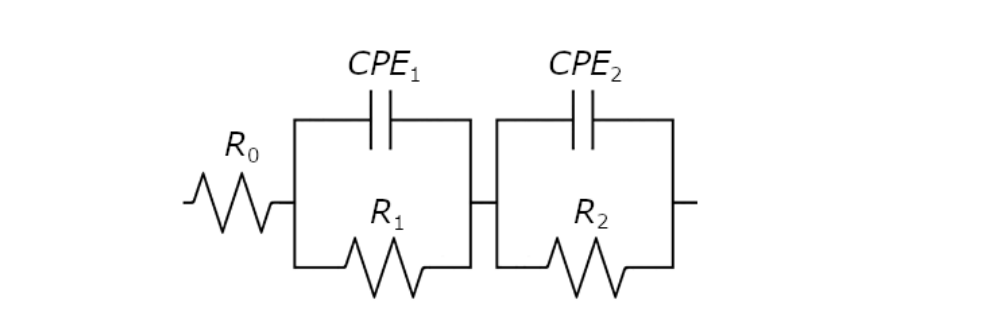
Figure 6. Equivalent electrical circuit model for the corrosion process used for CNLS-fitting. Figure 7. Bode plots versus log frequency ( log f ) for electrodeposited Pd, Pd-Rh, Pd-Ru and Pd-Pt electrodes in deaerated 0.5 M H 2 SO 4 at the open circuit potential: ( a ) Magnitude of impedance (log | Z |); ( b ) Phase angle (  ). Symbols represent experimental data. Continuous lines are fits obtained using the equivalent electrical circuit shown in Figure 6.